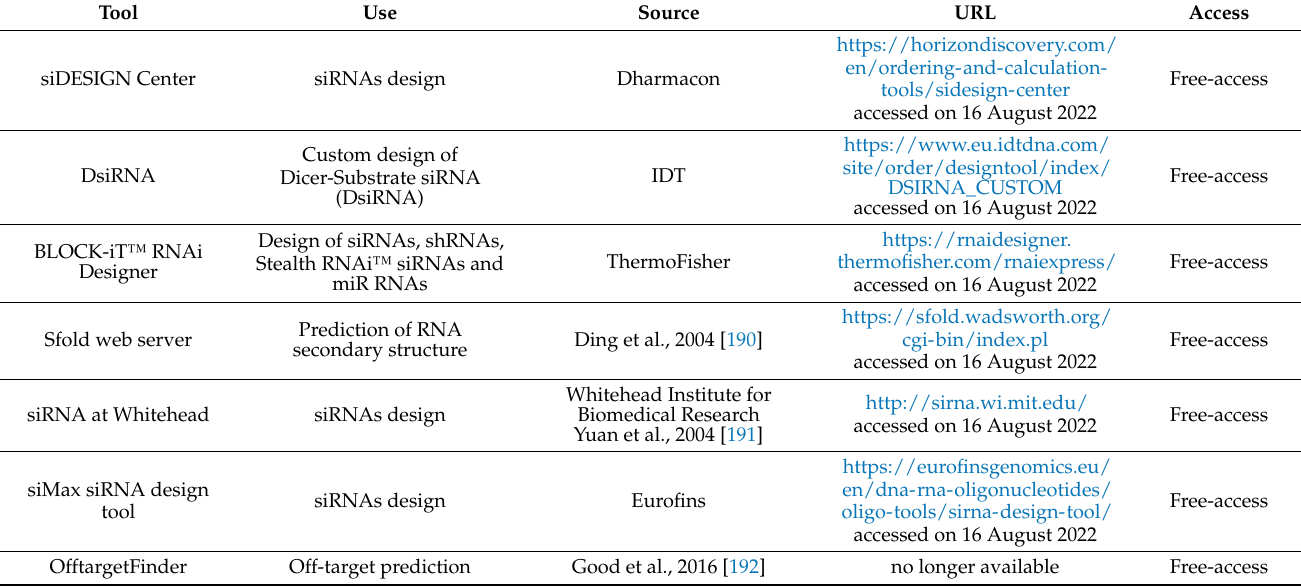
Table 3. List of web-based algorithms for the design of